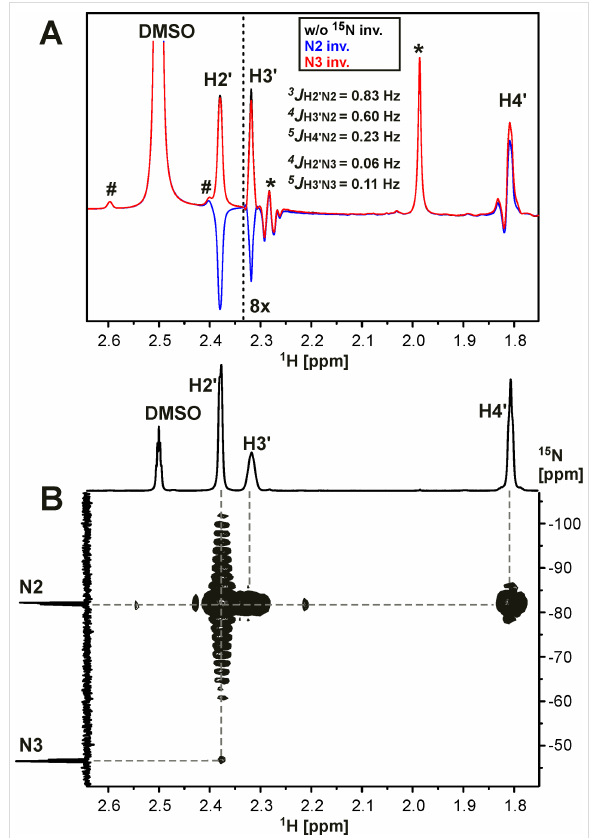
Figure 4: Detection and quantification of the 1 H- 15 N spin–spin interac- tions in compound 15a- 15 N 2 (DMSO- d 6 , 45 °C). (A) Fragment of the 1D 1 H amplitude-modulated spin-echo spectrum measured without (black trace) or with selective inversion of the 15 N2 (blue trace) or 15 N3 (red trace) nuclei. The spectrum was measured using a spin- echo delay (delay for the evolution of J HN ) of 1 s. The measured J HN values are listed. The signals of 13 C-DMSO at natural isotope abundance and the signals of impurities are marked by # and *, re- spectively. The concentration of these impurities relative to the con- centration of 15a- 15 N 2 does not exceed 2%. The up-field region of the spectrum is drawn with increased scaling. (B) Fragment of the 2D 15 N-HMBC spectrum of 15a- 15 N 2 . The 1 H- 15 N cross-peaks be- tween the adamantane protons and 15 N-labelled atoms are